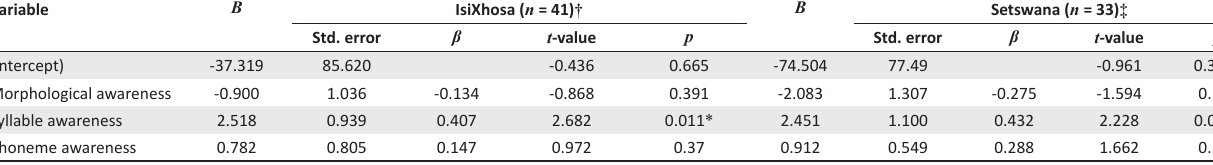
TABLE 5: Results of multiple regression analysis with oral reading fluency as a dependent variable.